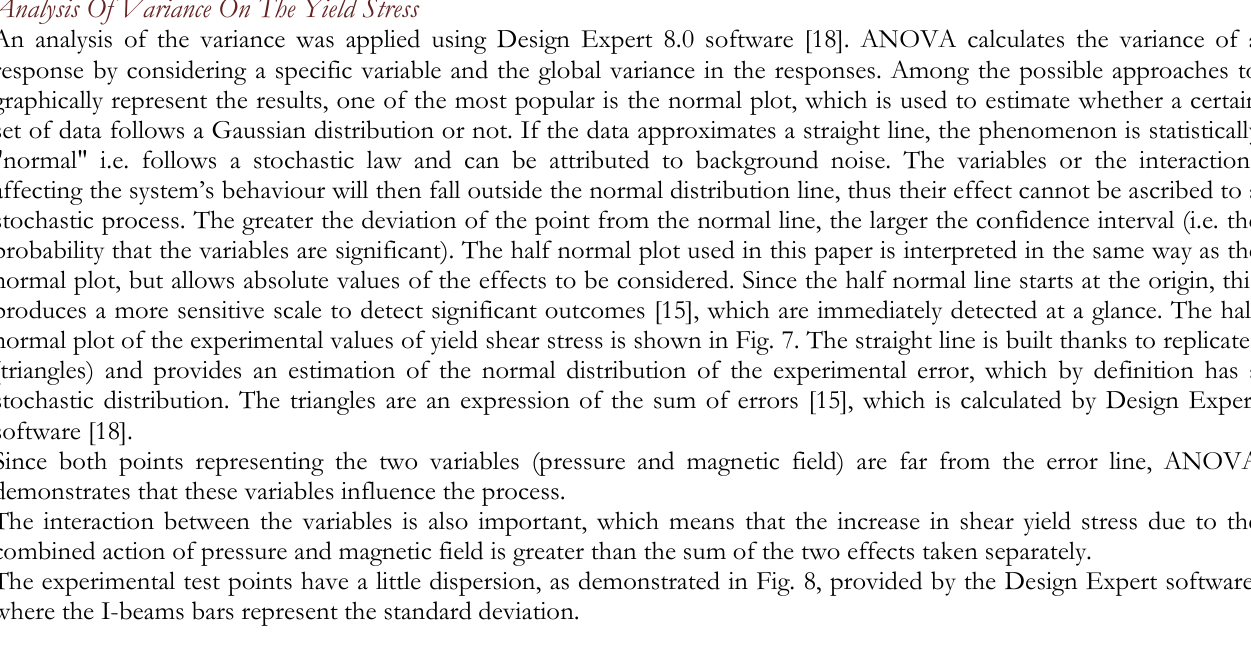
retrieved using Eq. y